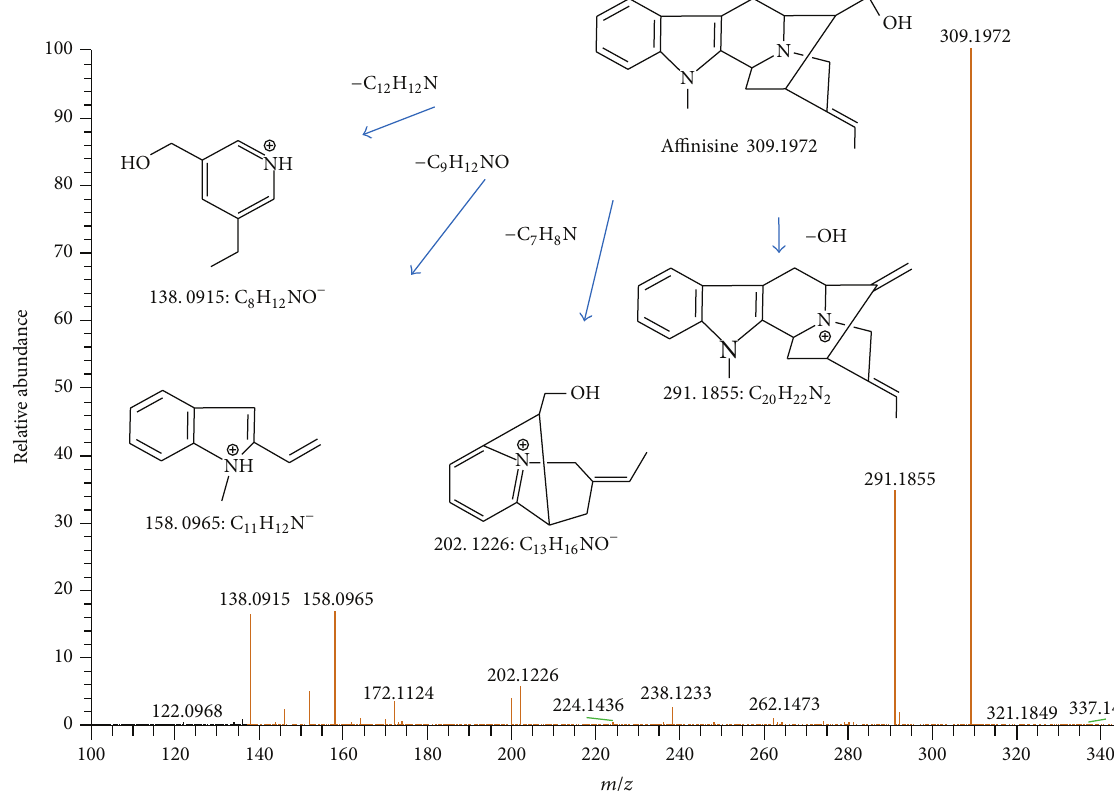
Figure 3: ESI(+)-MS/MS of